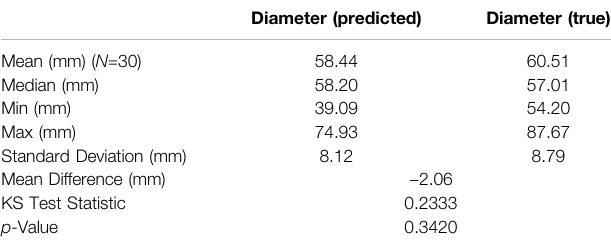
TABLE 5 | Kolmogorov-Smirnov test results for the large